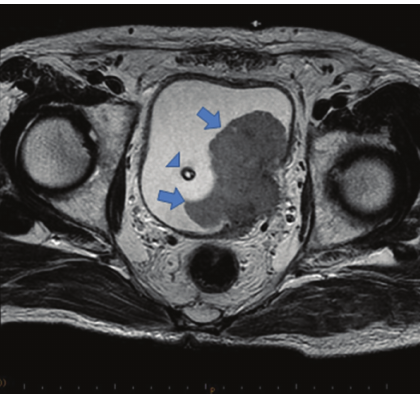
Figure 3: Surveillance-enhanced MRI scan showing enlargement of the right adrenal gland seven months after radical